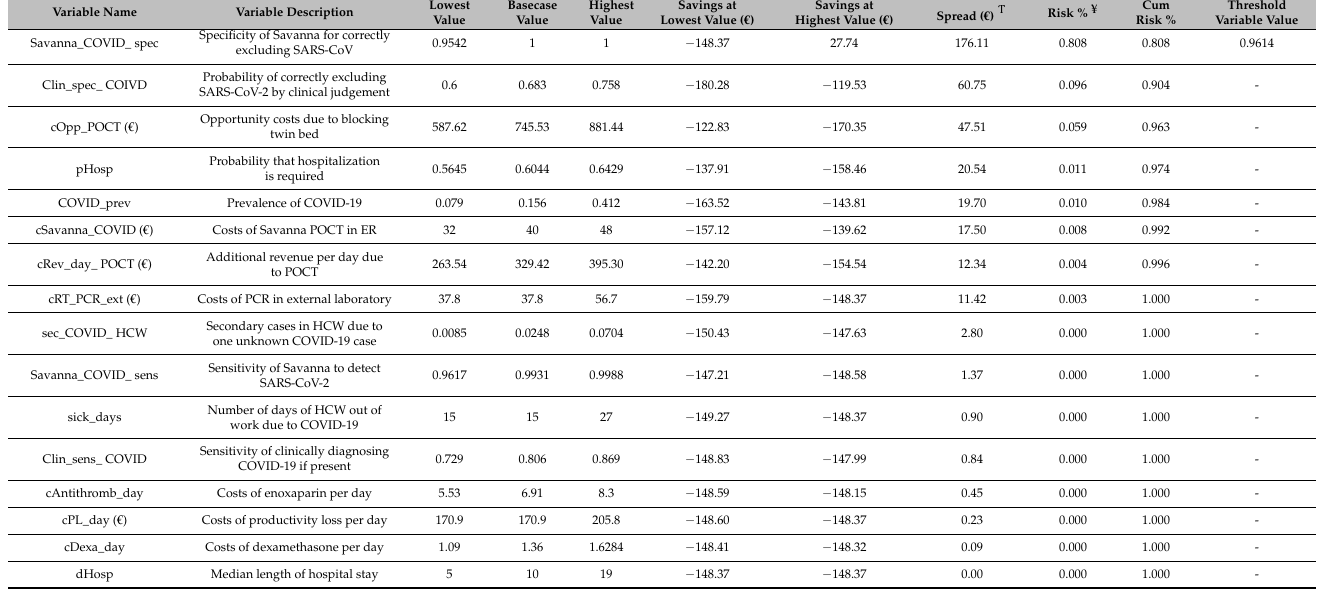
Table 3. Tornado diagram * (Savanna ® PCR-POCT versus the conventional clinical